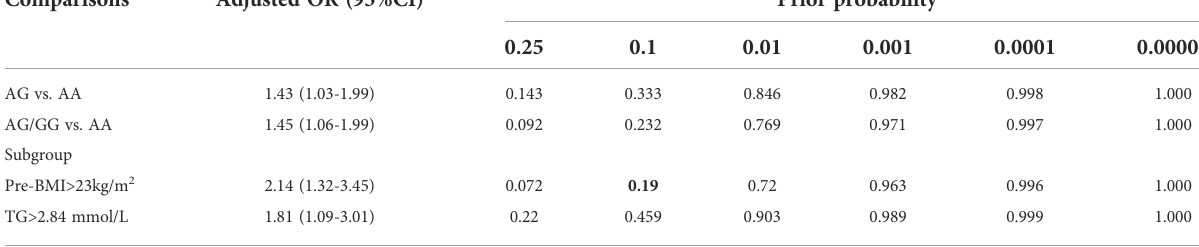
TABLE 6 FPRP analysis for the signi fi cant associations of the rs2106809 A>G and PE